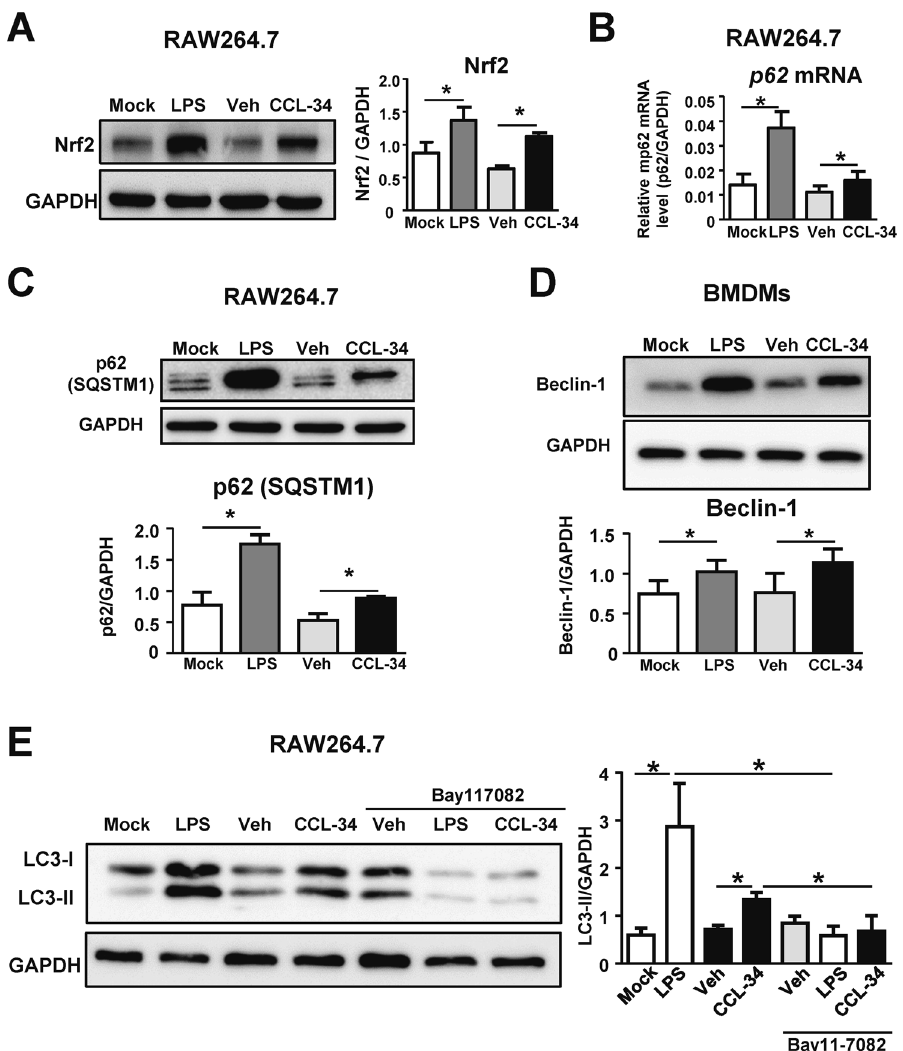
Figure 2. Involvement of the Nrf2-p62 axis, Beclin-1 induction and NF- κ B activity in CCL34-induced autophagy. (A – E) RAW264.7 cells or BMDMs were incubated with LPS (100 ng/mL), vehicle (0.1% DMSO), or CCL-34 (30 μ M). (A,B) RAW264.7 cells were treated with the candidate drugs for 12 hours. (A) CCL-34 induces Nrf2 protein expression. Nrf2 protein was detected by immunoblotting (n = 3), and (B) CCL-34 promotes p62 mRNA expression. p62 mRNA was detected by RT-qPCR (n = 6). (C) CCL-34 promotes p62 ptroten expression. RAW264.7 cells were treated with the candidate drugs for 24 hours and P62 protein was analyzed by immunoblotting (n = 3). (D) CCL-34 induces Beclin 1 protein expression. BMDMs generated from C57BL/6 were incubated with candidate drugs for 24 hours and the Beclin 1 protein was measured by immunoblotting (n = 5). (E) NF- κ B activation is involved in CCL-34-mediated autophagy. RAW264.7 cells were treated with Bay11-7082 (10 μ M) for 1 hour and then incubated with the candidate drugs for 24 hours. LC3-II protein was detected by immunoblotting (n = 3). The results were plotted using GraphPad Prism version 8.1.0 (www. graphpad.com). All the data are shown as the mean ± SD, and * p < 0.05 indicates a significant difference versus the medium control or vehicle control analyzed using Student’s t-test. Total protein (50 μ g for RAW 264.7 cells or 25 μ g for BMDM) were analyzed using immunoblotting. The uncropped full-length blots of ( A ), ( C ), ( D ), ( E ) are shown in Supplementary Figure